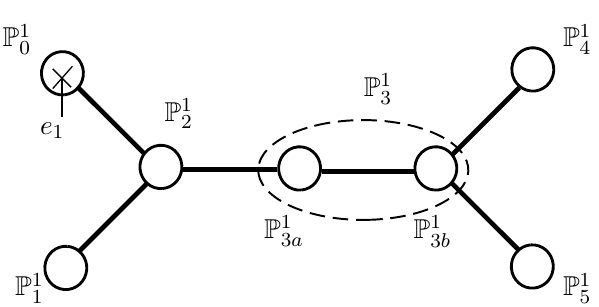
3 d 5 (cid:0) d 1 d 7 = 0 locus. The a(cid:14)ne node . 3